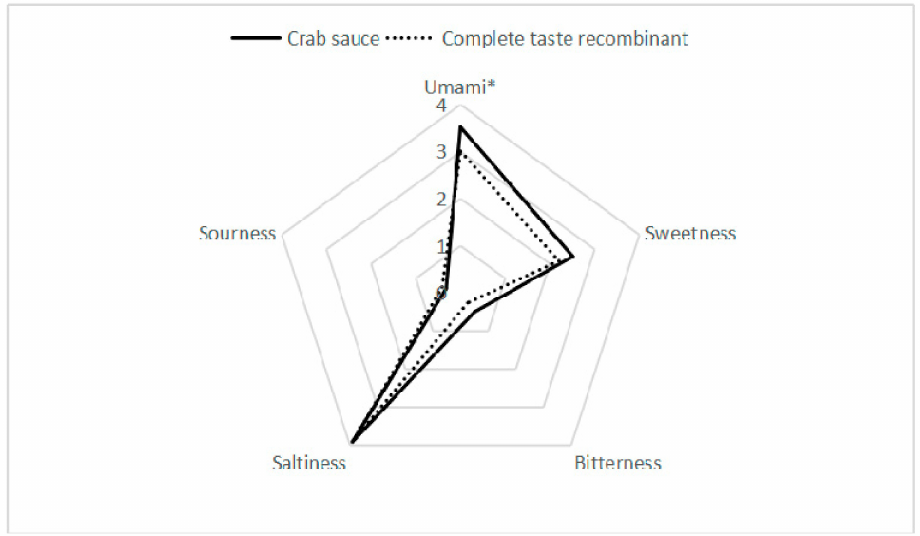
Figure 1. Taste profile of crab sauce (solid line) and the complete taste recombinant containing 24 compounds (dotted line). * significant di ff erence ( p <